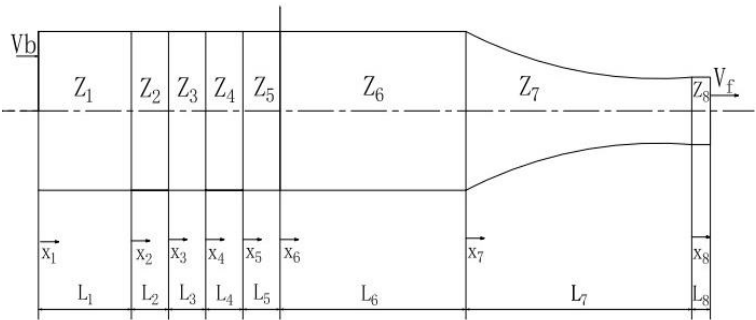
Figure 1. Structural diagram of longitudinal – torsional transducer.